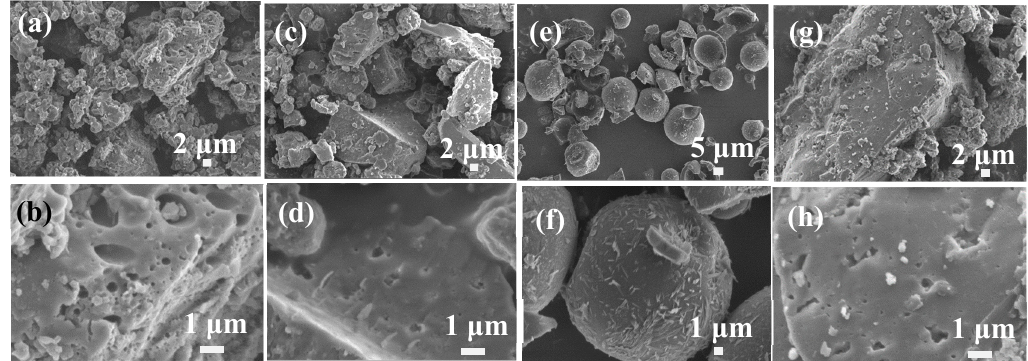
Figure 1. SEM images of four typical types of lignin including ( a,b ) Kraft lignin, ( c,d ) hydrolysate lignin, ( e,f ) alkali lignin, and ( g,h ) Longlive lignin.